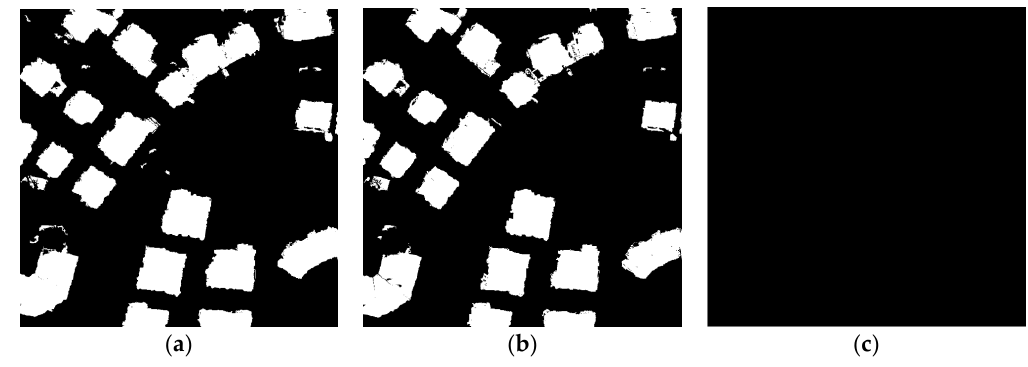
Figure 11. The result of Area37: ( a ) the result of DBN; ( b ) the result of SSAE; and ( c ) the result of SVM. Table 6. Different methods of extraction results.